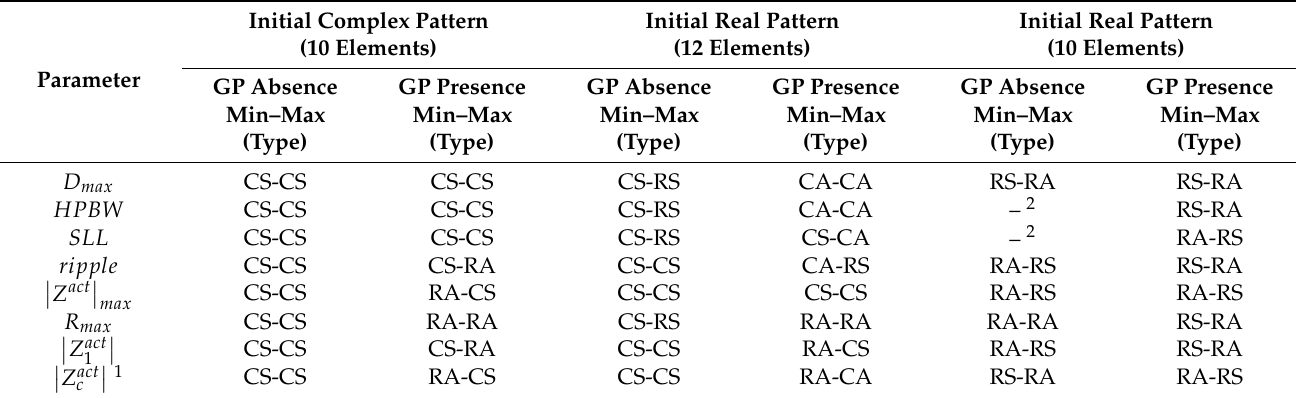
Table 7. Nature of the solutions related to the maxima and minima bandwidths in terms of quality parameters of the pattern and selected terms for the resonant linear antenna array in absence and presence of ground